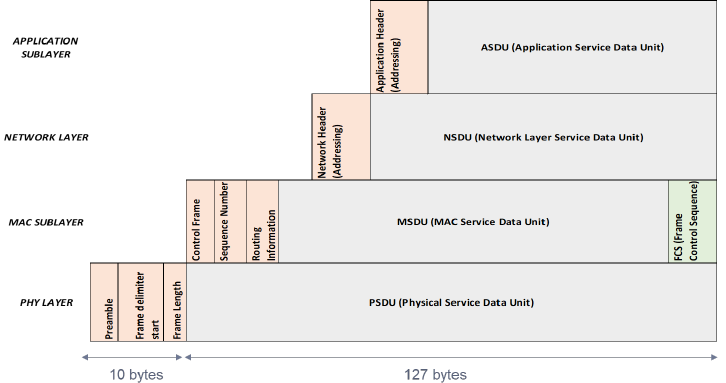
Figure 16. Data Units in the layer structure.